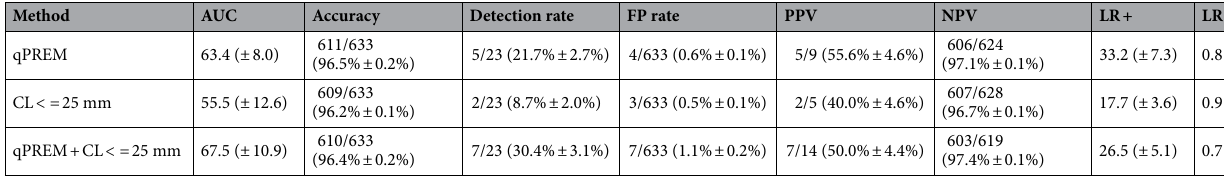
Table 2. Results for sPTB < 37. N = 633, 23 cases, 610 controls (prevalence 3.6%). qPREM QUANTUSPREMATURITY, CL cervical length, FP Rate false positive rate, PPV positive predictive value, NPV negative predictive value, LR + positive likelihood ratio, LR − negative likelihood ratio.